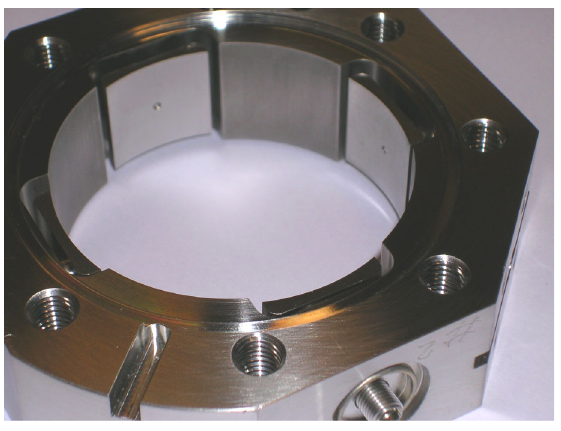
FIG. 9. (Color) An IPHI BPM (core, feedthrough, and assem- blies) has been built by the French company PMB. The space between electrode and core is 2 mm with a tolerance of (cid:1) 0 : 05 mm . The four standard Metaceram 50 (cid:1) feedthroughs